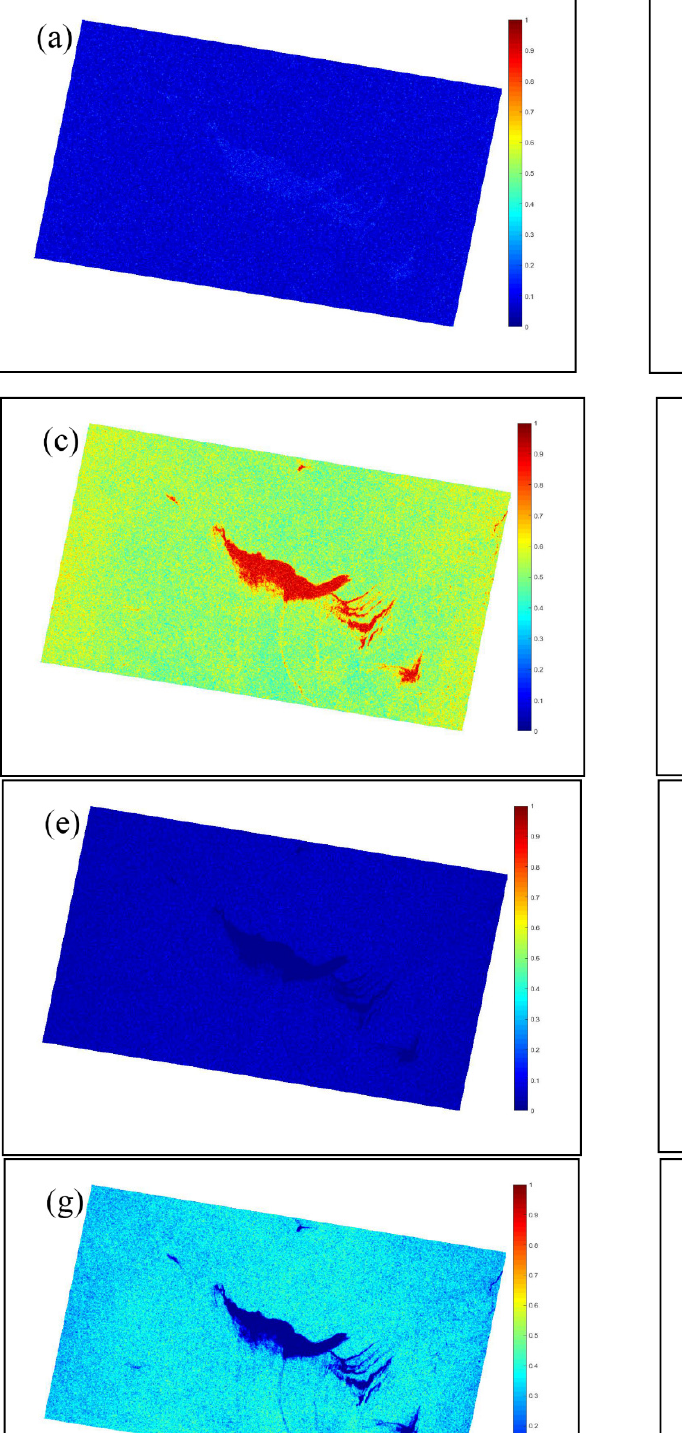
A 12 ). ( e ) A *(1 − H ). ( f ) A 12 *(1 − H ). ( g ) (1 − H )*(1 − A ). ( h ) (1 − H )*(1 − A 12 ).